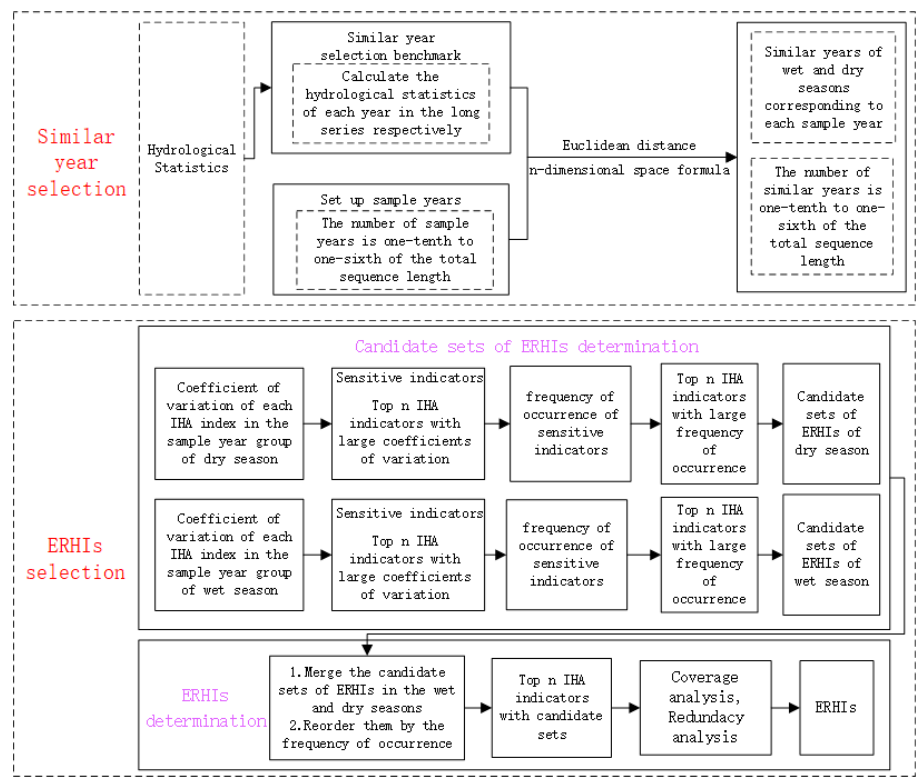
Figure 2. ERHIs selection process.